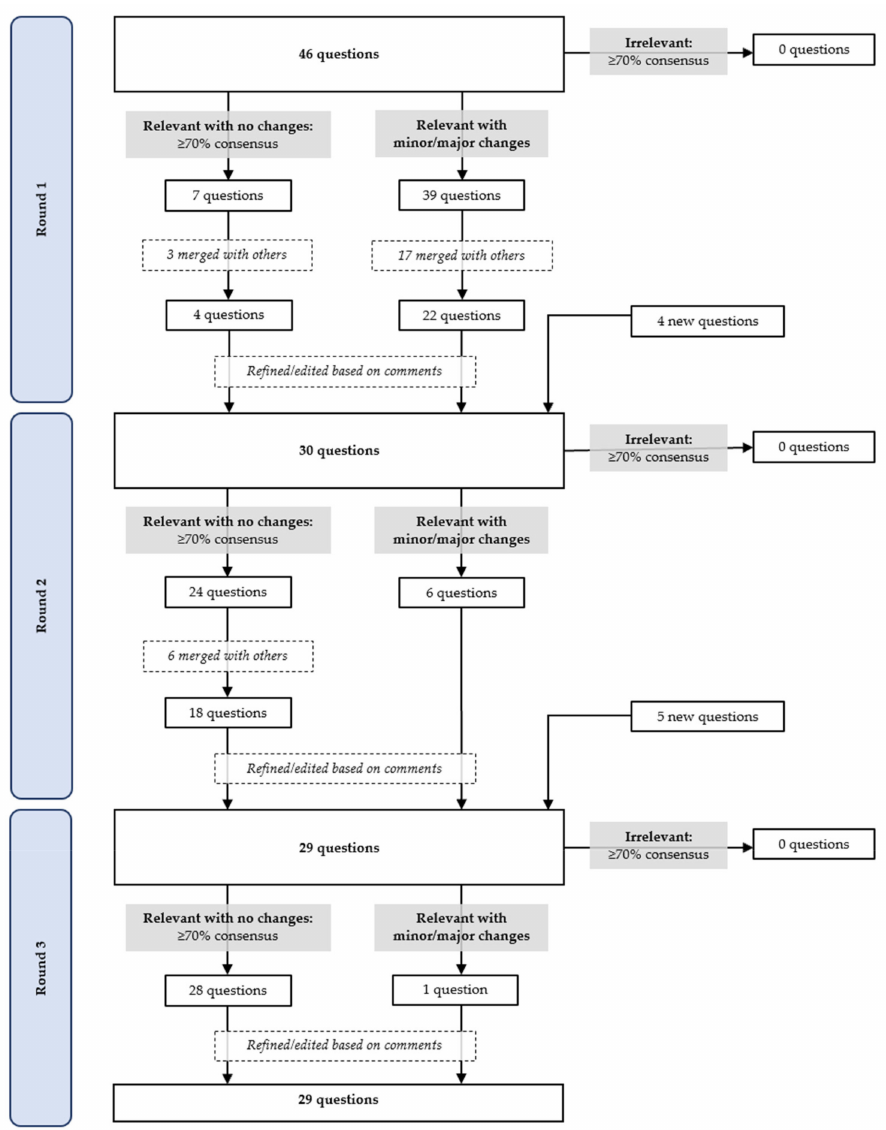
Figure 3. Flow chart of the elimination and addition of questions in the Chrononutrition Question- naire through Rounds 1 to 3 based on consensus of ratings and feedback from the expert